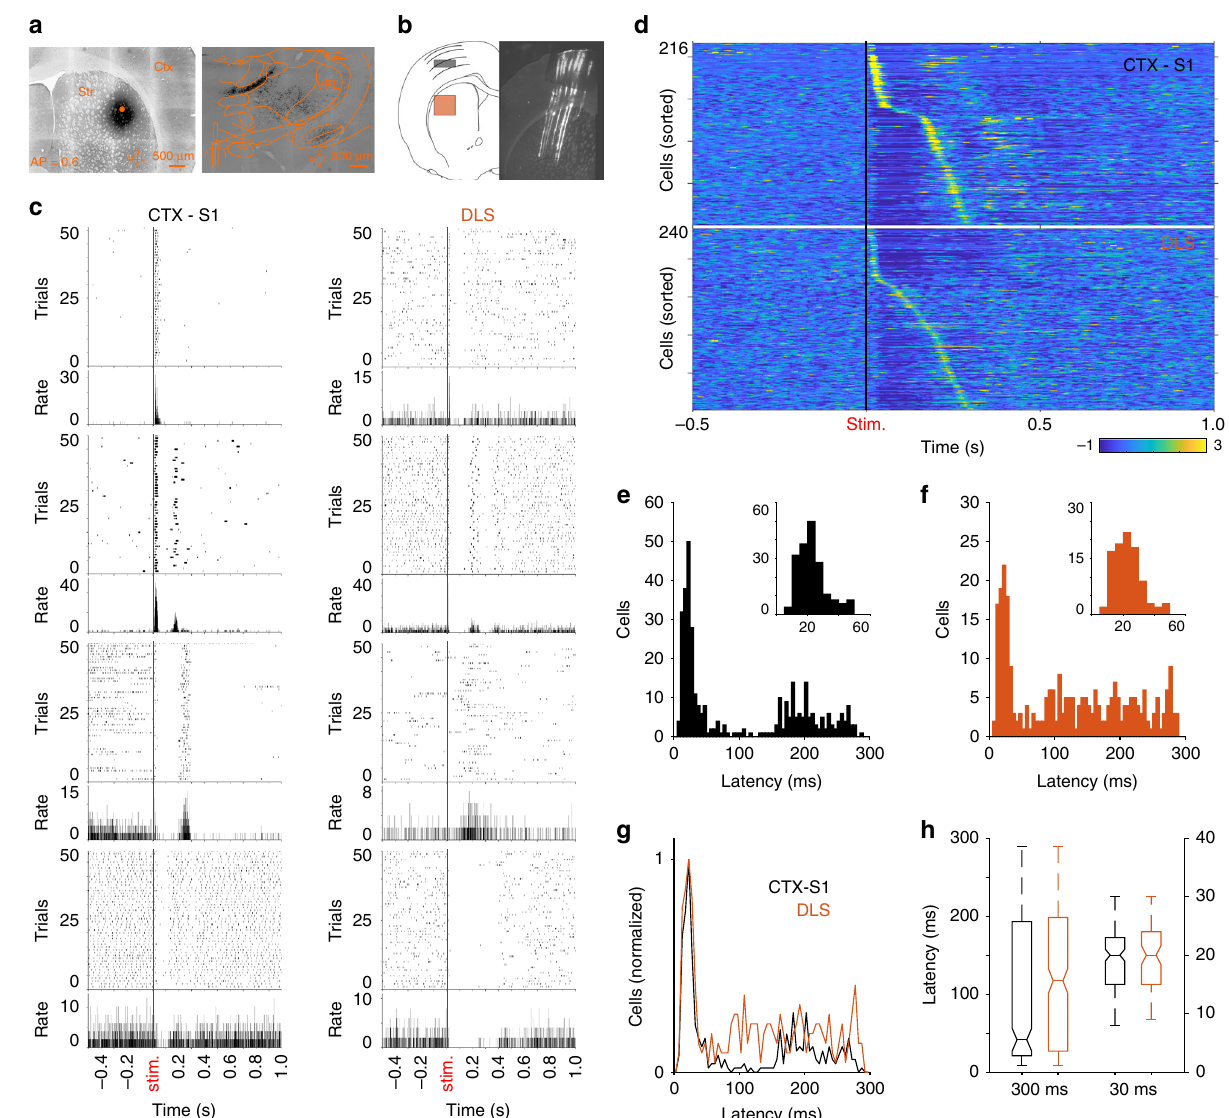
Fig. 1 Sensory fl ow in the DLS and S1. a Micrographies show the site of injection of Fluorogold in the DLS (left), stained cells in the thalamus, including the VPL (right). b Schematic view of the site of recordings and histological con fi rmation of the silicon probe position in S1 and DLS. c Activity of eight illustrative units aligned to the stimulation onset of the forelimb contralateral to the recording site. Spike rasters (top) and average peri-event histograms (bottom) are depicted for cells with different response patterns recorded in S1 (left column) and DLS (right column). d Averaged fi ring rates for cells recorded in S1 (top) and DLS (bottom) expressed as Z -score (color coded) and sorted according to the time they reached the highest activity after stimulus onset. Histograms of the response latencies for all cells recorded in S1 ( e ) and DLS ( f ); for better appreciation, insets display latencies shorter than 60 ms. g Overlap of latency distributions in both regions. h Comparison of the response latencies for the entire population of cells (left) and for the cells with latencies shorter than 30 ms